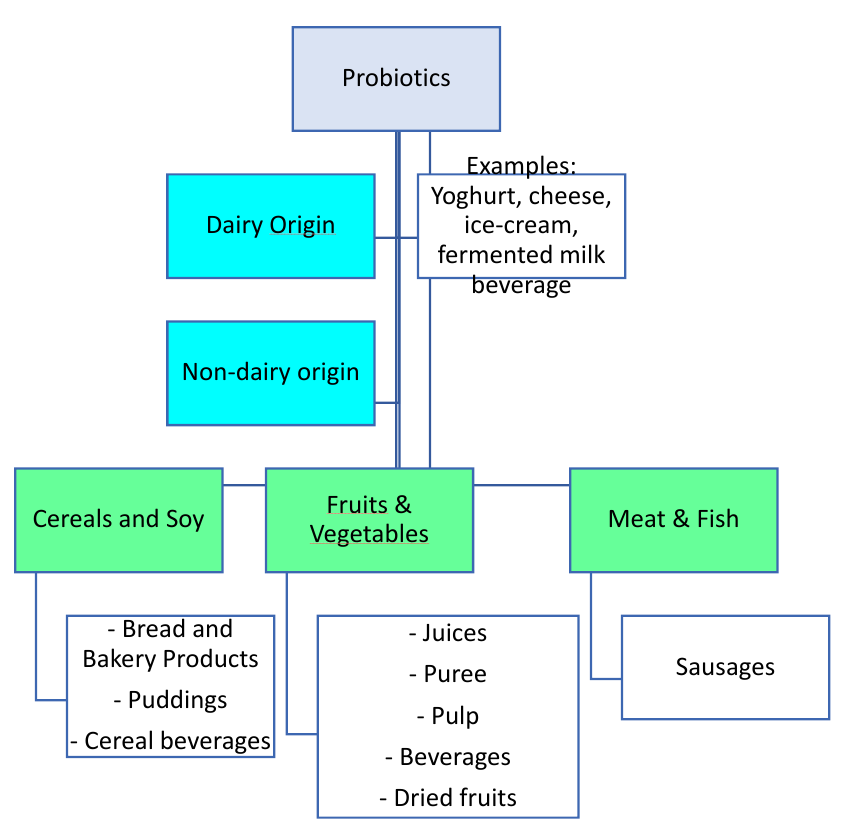
Figure 1. Classification of probiotic foods .